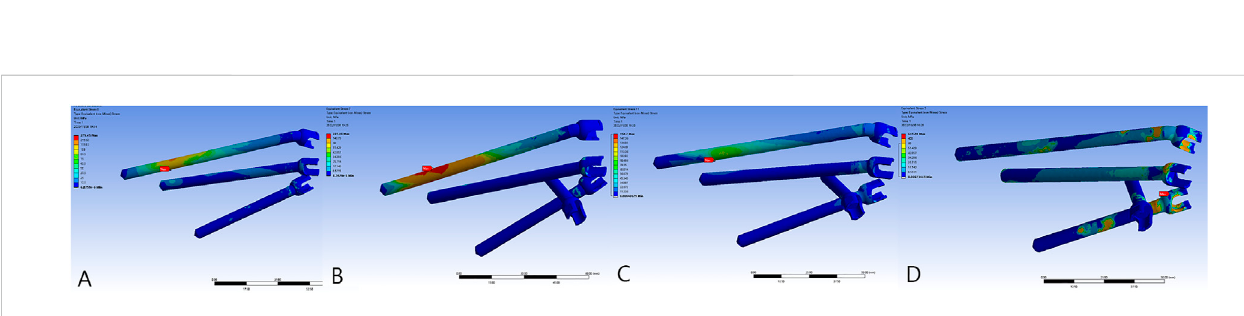
FIGURE 5 The von Mises force of the sacral screws. The three horizontal screws were L5, S1, and S2 screws from top to bottom. (A) Model 1_B. (B) Model 2_B. (C) Model 3_B. (D) Model 3_E.